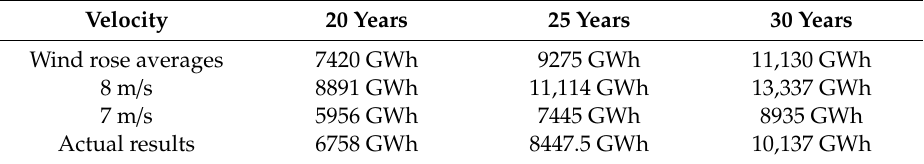
Table 15. Electricity production with di ff erent wind speeds over the di ff erent